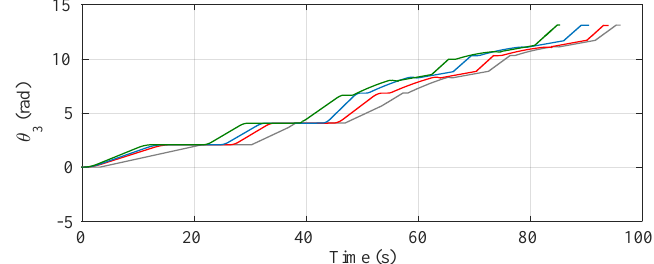
Figure 30. Behavior of the angular position of the driving wheels ( θ 3 ) when the path is optimized with α = 0 ( — ), α = 0.5 ( — ) and α = 1 ( — ) and when the optimization is not considered ( —